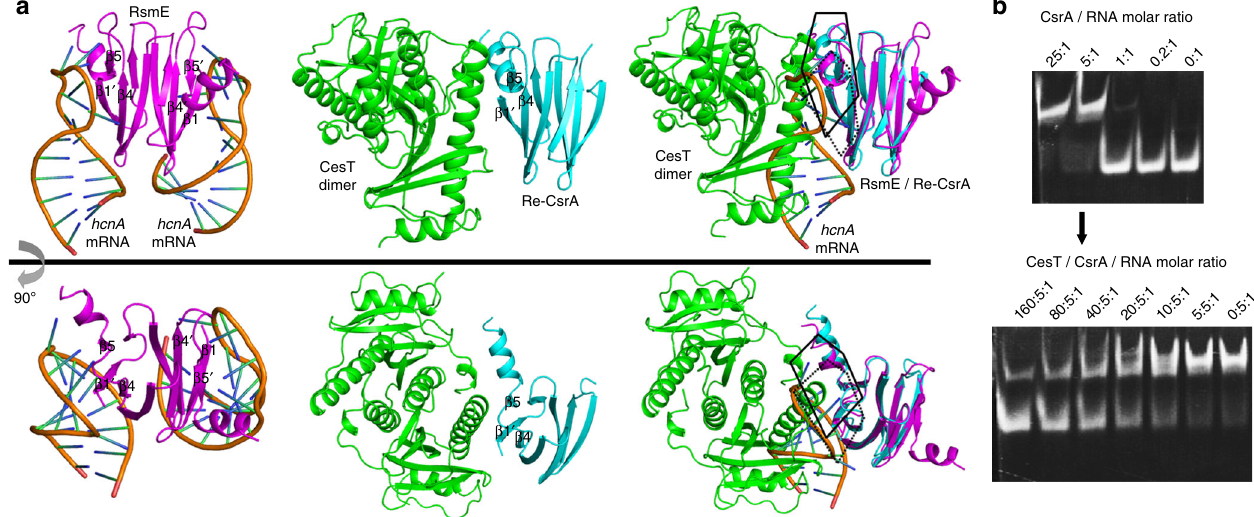
Fig. 5 Competition of the CsrA/mRNA binding by CesT. a Side-by-side views of the structures of RsmE bound with hcnA mRNA (left), Re-CsrA bound with CesT (middle), and the superimposition of the two structures (right). Those shown in the top panel are clockwise rotated for about 90° around a horizontal axis to yield the structures exhibited in the bottom panel. The RsmE/CsrA structural elements involved in binding to both mRNA and CesT are highlighted and labeled. The identi fi ed RNA-binding site in RsmE and the CesT-binding site in Re-CsrA are encircled with dashed and solid lines, respectively. Clearly shown is that the RNA binding site in RsmE and the CesT binding site in CsrA extensively overlap with each other. b An RMSA experiment characterizing the CsrA repression by CesT. An RNA molecule derived from nleA 5 ′ UTR was utilized as the RNA probe for CsrA binding. The resolved native TBE-PAGE gels are shown. Top panel: WT CsrA mixing with RNA at the indicated molar ratios. Bottom panel: pre-incubated CsrA/RNA (at 5:1 molar ratio) mixture with different concentrations of